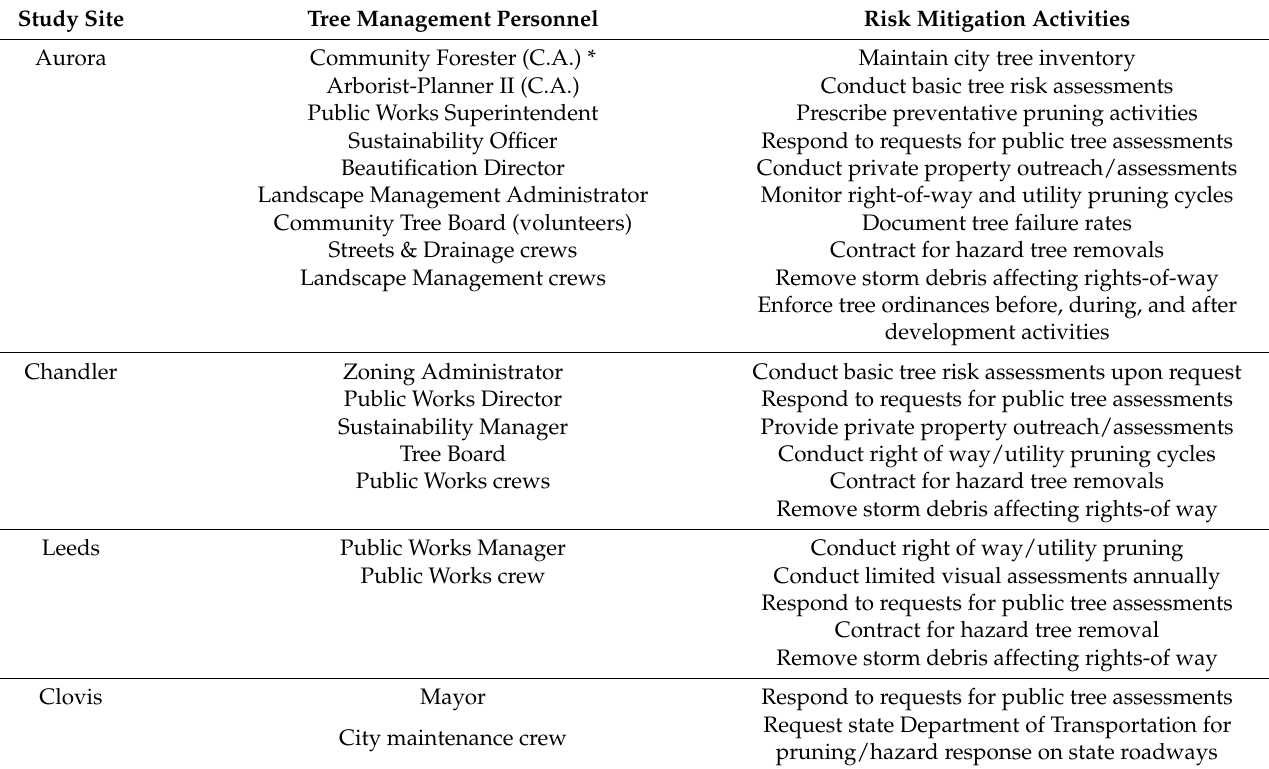
Table 3. City tree management personnel and risk management activities by study